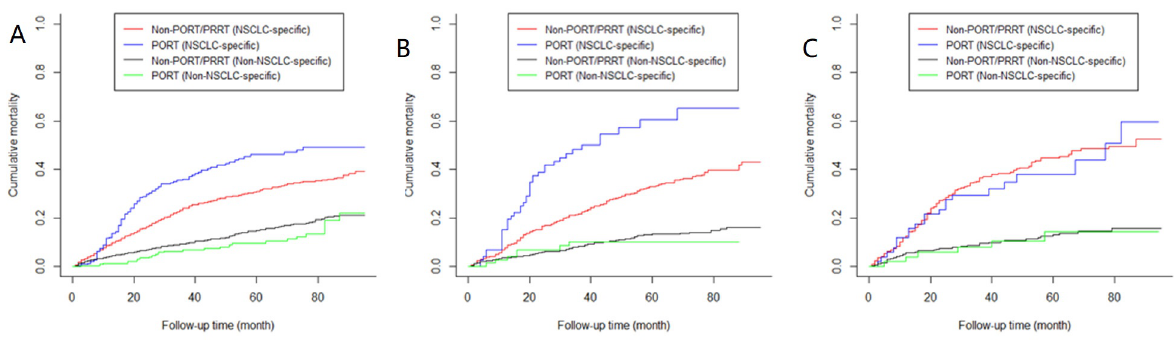
Figure 6. Competitive risk analysis for NSCLC-specific death of patients with ( A ) N0 stage caused by using PORT ( p < 0.001); ( B ) N1 stage featured < 3 positive nodes caused by using PORT ( p < 0.001); ( C ) N1 stage featured ≥ 3 positive nodes caused by using PORT ( p = 0.783). Note: NSCLC = non-small cell lung cancer; PORT = postoperative radiotherapy; PRRT = preoperative radiotherapy; Non-PORT/PRRT = neither PORT nor PRRT.